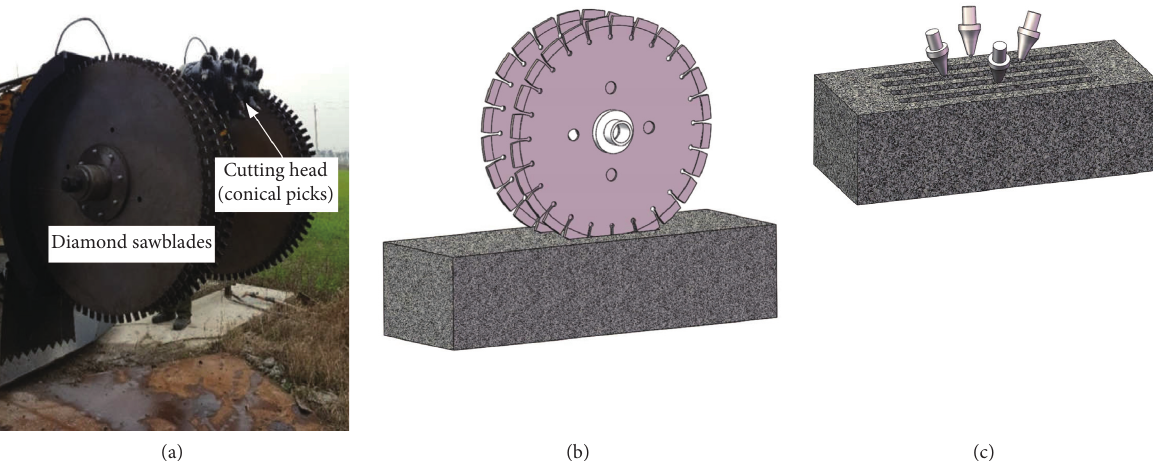
Figure 1: Rock breaking machine combination of diamond sawblades and conical picks: (a) the diamond sawblades and conical picks combined roadheader prototype, (b) the diamond sawblades cutting rock model, and (c) the conical picks cutting rock arc rock plate.